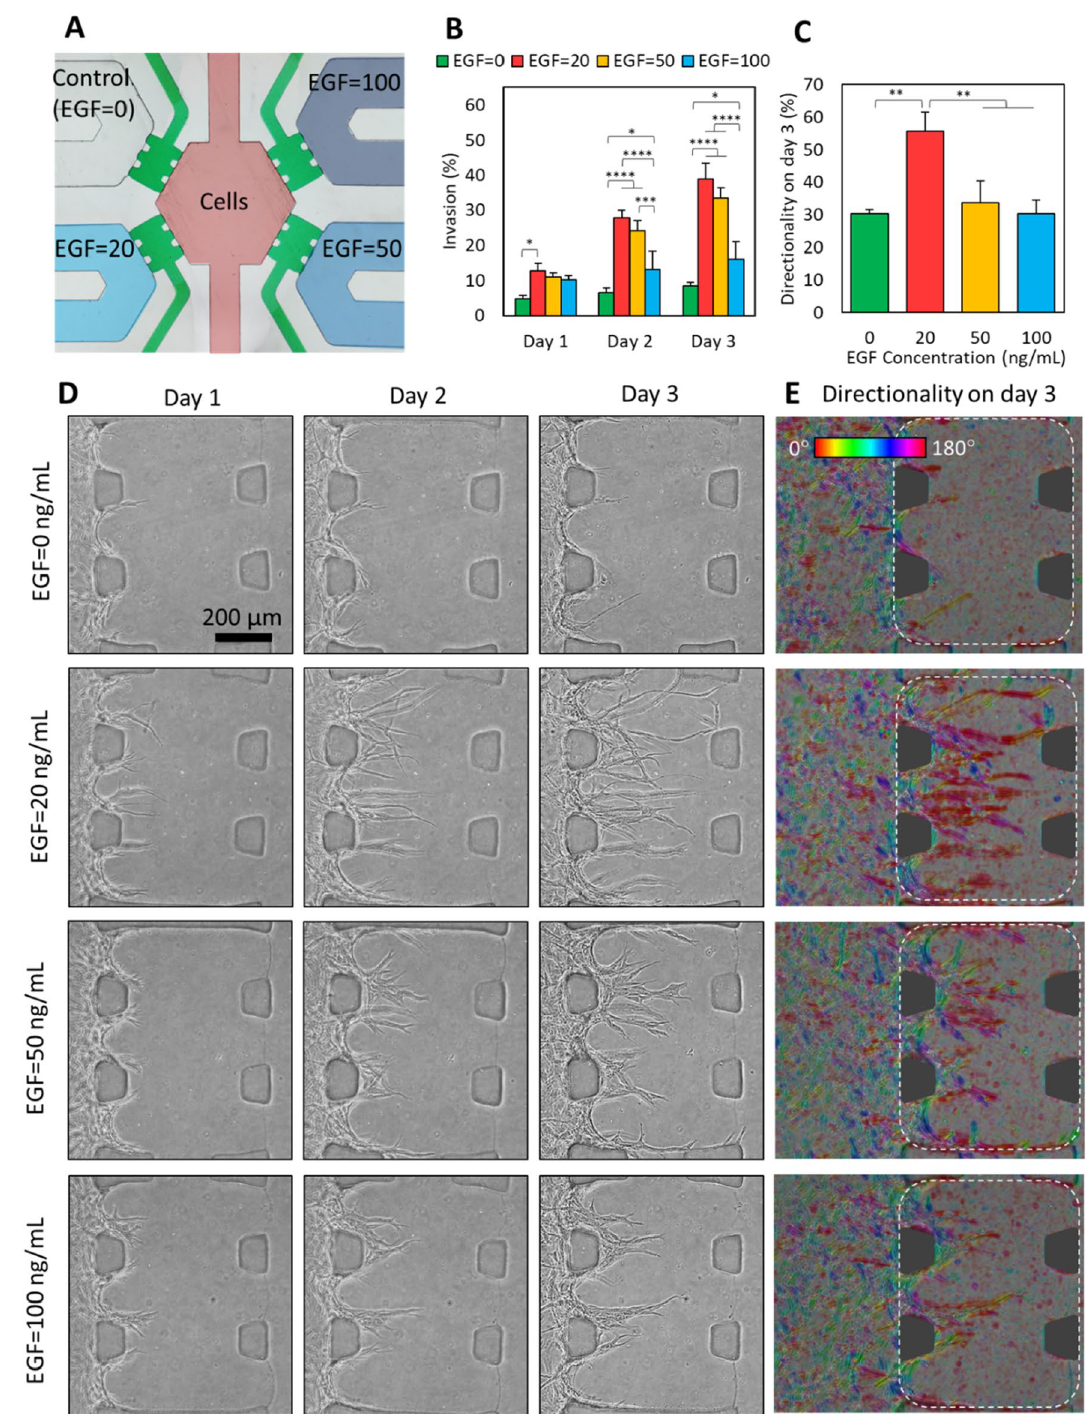
Figure 5. The dose-dependent response of the MBA-MD-231 cells to EGF gradients. ( A ) The design of the experiment in each microfluidic device. The numbers represent the concentration of the EGF in ng/mL. ( B ) The invasion levels of MBA-MD-231 cells in response to different EGF gradients. The invasion levels were measured from the area of ECM occupied by the cells. ( C ) The directionality of the invasive cells at day 3 post-seeding, in response to different EGF gradients, obtained using ImageJ software. ( D ) Representative images of each gradient section of a single device on different days post-seeding. ( E ) Qualitative representation of the cellular directionality. A color map is generated using ImageJ software to demonstrate the random orientation of the cells in the cell culture chamber and their directionality in the ECM section. A reddish color indicates the direction of the invasion aligned with the concentration gradient direction. For a better comparison, all figures rotated to position the cell culture chamber at the left and EGF signal channel at the right side of the image. The whole device that is used in ( D ) and ( E ) is shown in Figure